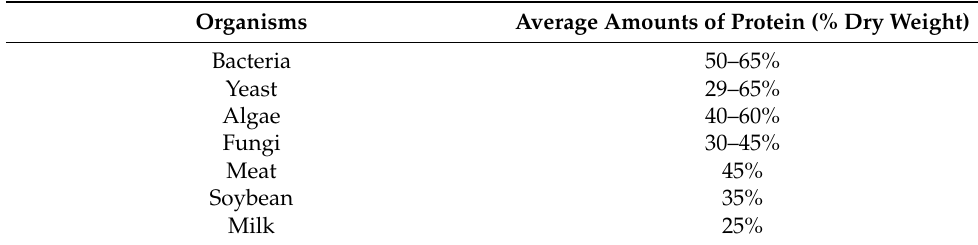
Table 2. Average amounts of protein production of several protein sources (% dry weight)